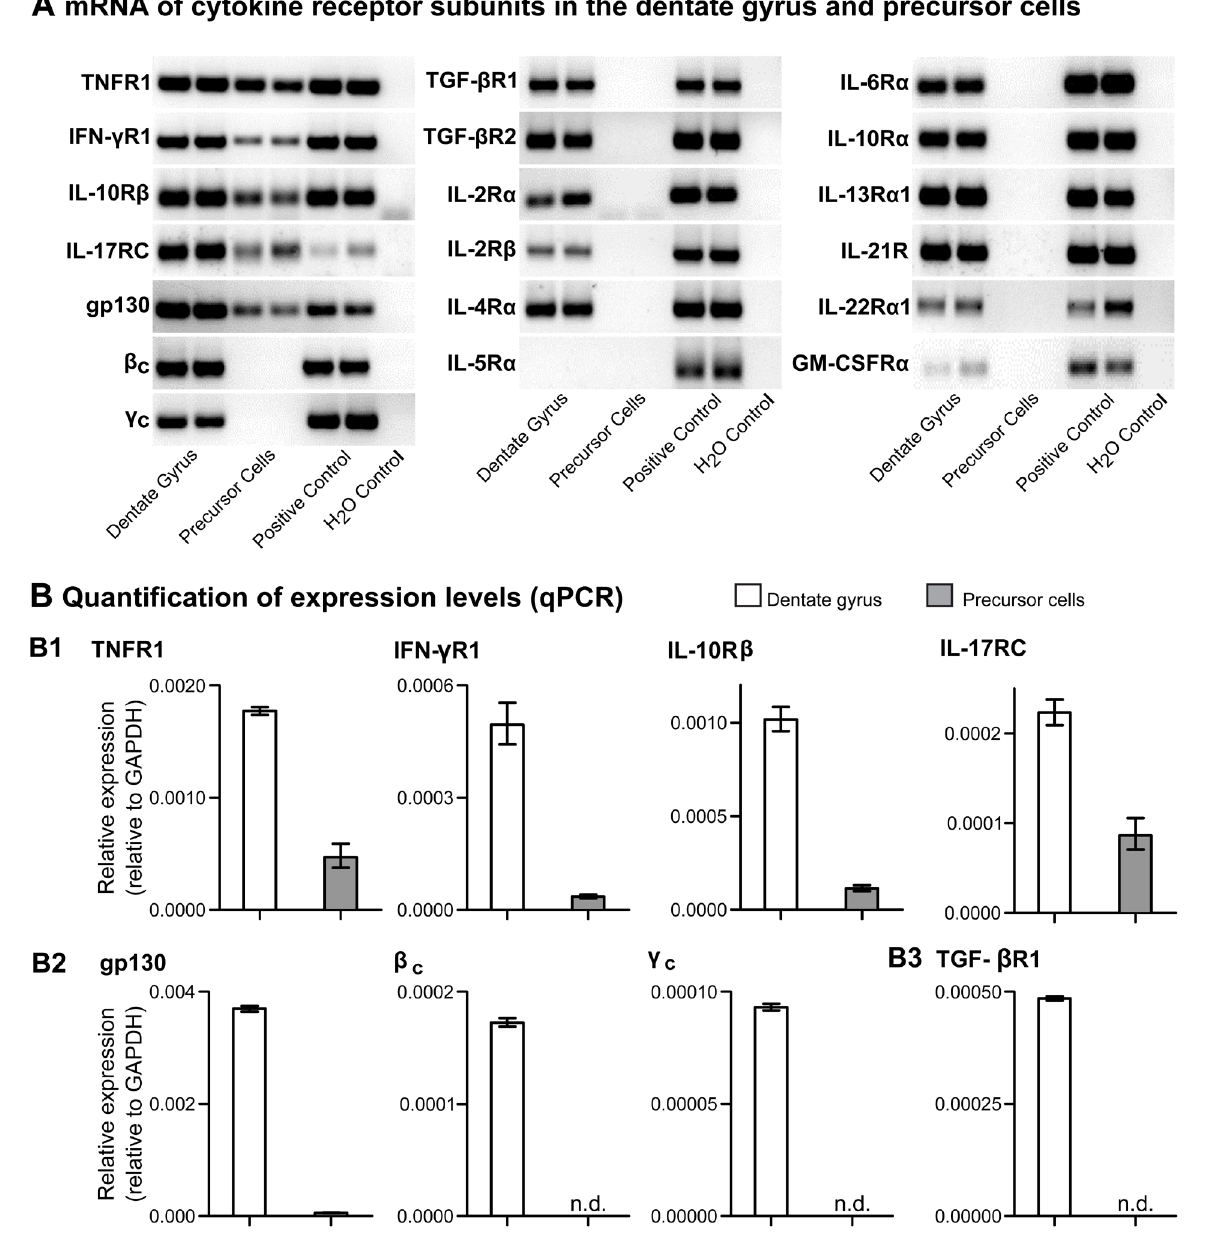
Figure 3. Cytokine receptor expression in the neurogenic niche of the hippocampal dentate gyrus. Freshly microdissected tissue and cultured neural precursor cells from the dentate gyrus of adult Nestin GFP and C57BL/6 wild-type mice were subjected to mRNA expression analysis of T cell-relevant cytokine receptor genes by real-time RT-PCR, as indicated. ( A ) Gel electrophoresis of RT-PCR duplicate samples. For details on indicated cytokine receptor genes, see below. Total cells from spleen and pooled lymph nodes were included as positive control. ( B ) Quantification by real-time RT-PCR. Relative mRNA expression values of indicated genes encoding cytokine receptor subunits, as revealed by quantitative RT-PCR using GAPDH for normalization. Only mRNAs with an expression below Δ Ct = 15 were considered to be expressed (n.d., not detected). Shown are mean values ± range of duplicate samples. (B1) Receptor subunits for essential T cell effector cytokines, including Th17 cell-derived cytokines, were expressed in the dentate gyrus as well as isolated precursor cells. TNFR1, IFN- γ R1, IL-10R β and IL-17RC are components of the receptors for TNF- α , IFN- γ (Th1), IL-10 (Treg/Th2) as well as IL-22, IL-17A and IL-17F (Th17). (B2) Shared receptor subunits of class I cytokine receptors (glycoprotein 130, gp130; common beta subunit, β were expressed in the dentate gyrus but, with the exception of gp130, not by the isolated precursor cells. Similar results were obtained for TGF- β R1, TGF- β R2, IL-2R α ( Δ Ct = 17,86), IL-2R β ( Δ Ct = 16.75), IL-4R α, IL-6R α , IL-10R α, IL-13R α 1, IL-21R, IL-22R α 1 ( Δ Ct = 18.78) and GM-CSFR α ( Δ Ct = 19.22). As a representative example, relative mRNA expression values for TGF- β R1 are shown (B3). Expression of the cytokine receptor mRNA for IL-5R α could be detected neither in microdissected tissue nor in cultured precursor cells from the dentate